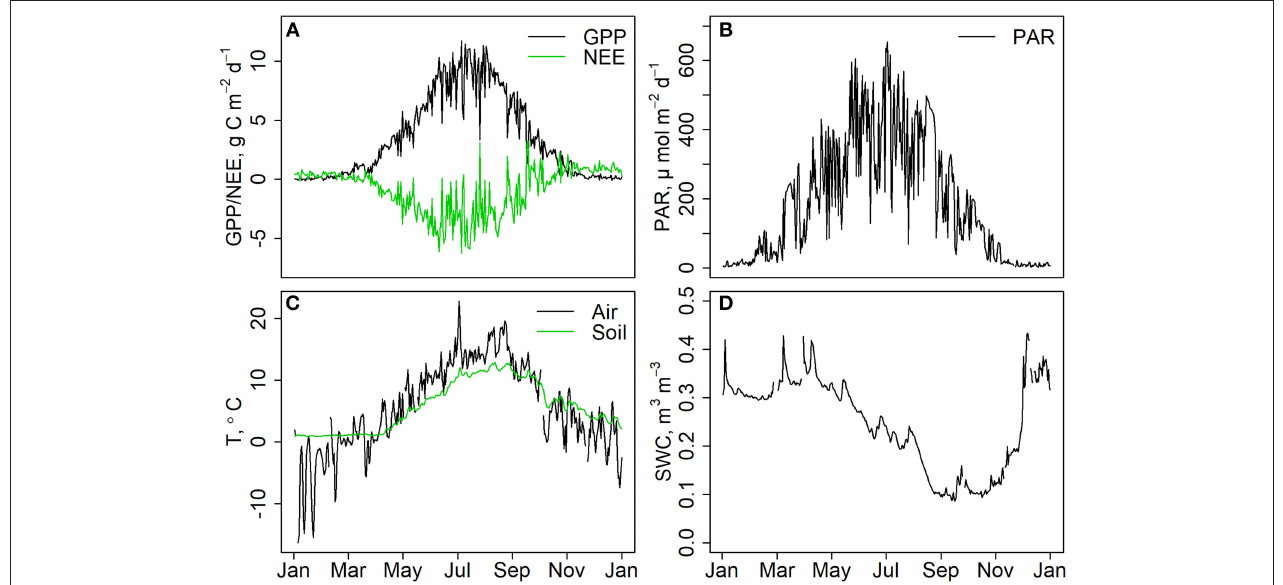
FIGURE 1 | (A) Daily gross primary production (GPP) and net ecosystem exchange (NEE), measured with eddy covariance technique in the study year 2015. Negative NEE indicates that the forest was a sink of carbon. (B) Daily mean PAR radiation at the canopy height, (C) daily mean air and soil temperature in A-horizon. (D) Soil water content in upper B-horizon.